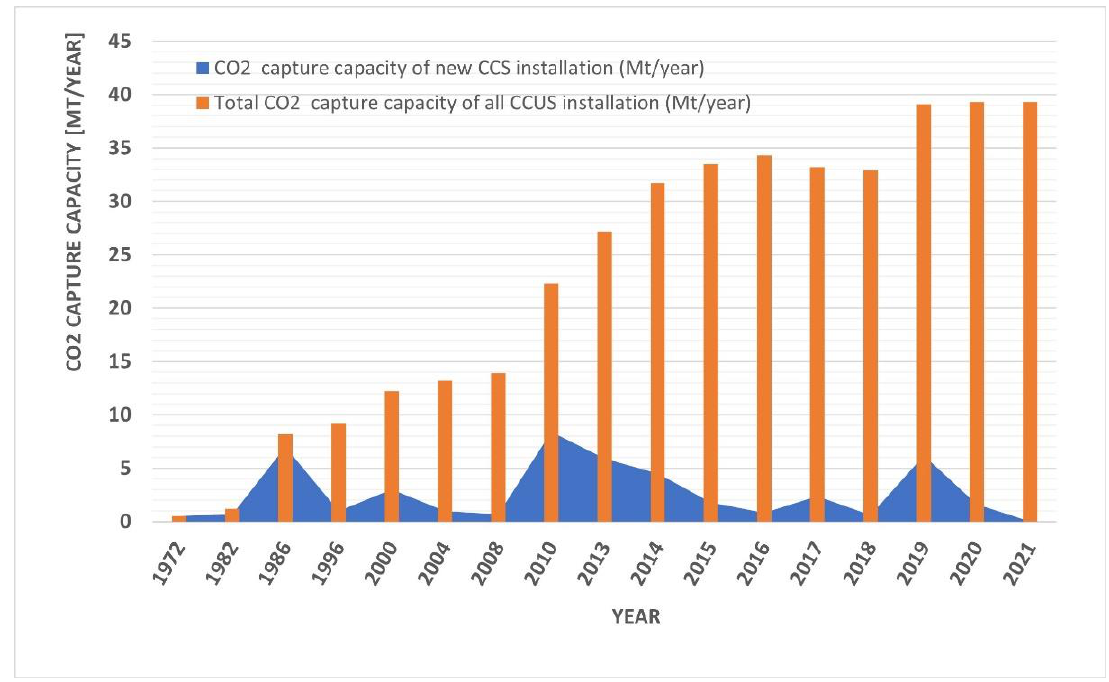
Figure 11. Total capacity and new large-scale CCUS installations capacities in 1972–2021 [6,64,66–